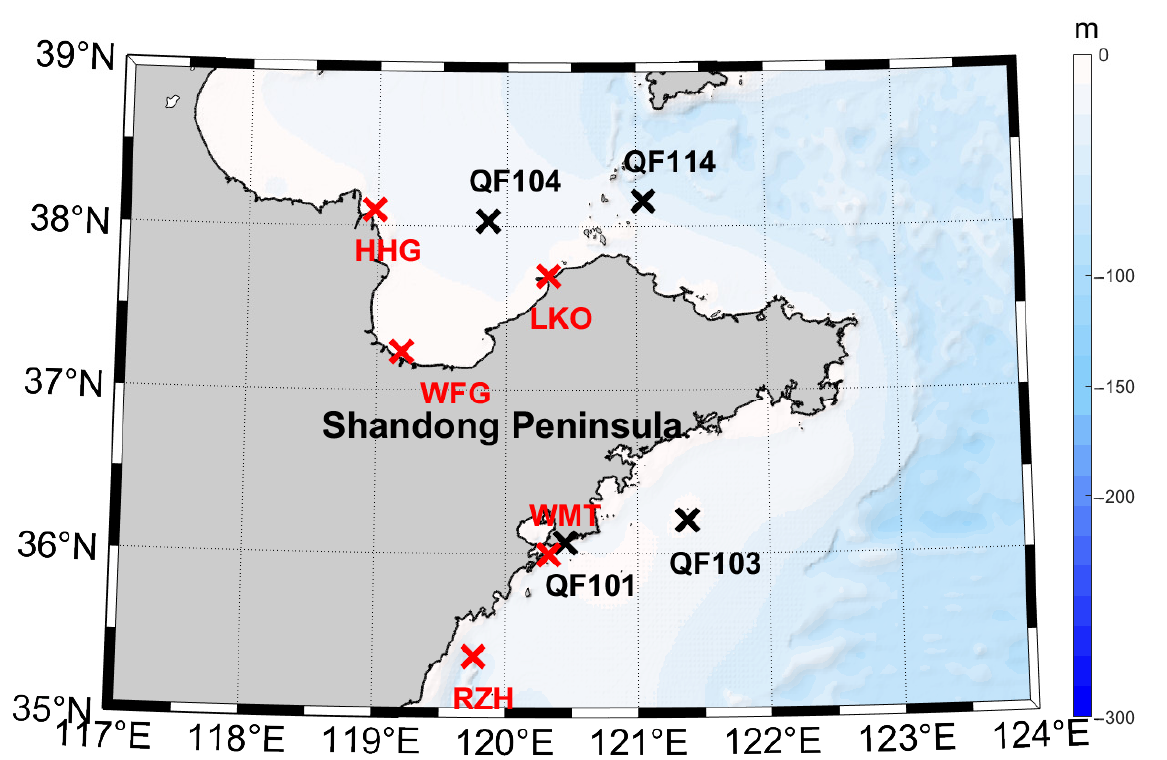
Figure 3. Landforms of the Northern East China Sea. Locations of buoys (QF101, QF103, QF104, and QF104) and stations (HHG, WFG, LKO, WMT, and RZH) are marked.